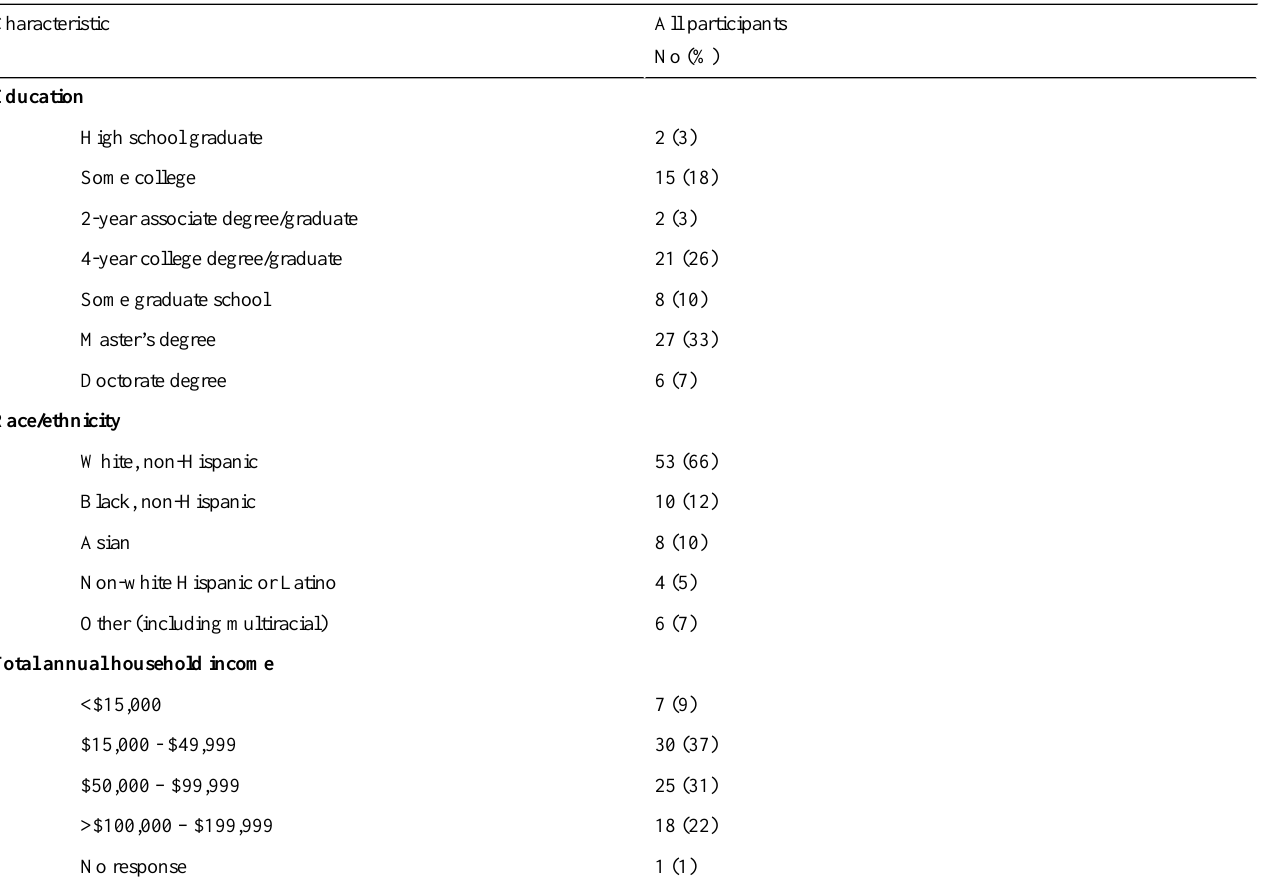
Table 2. Demographic and education characteristics of all women (n=81) randomized to all